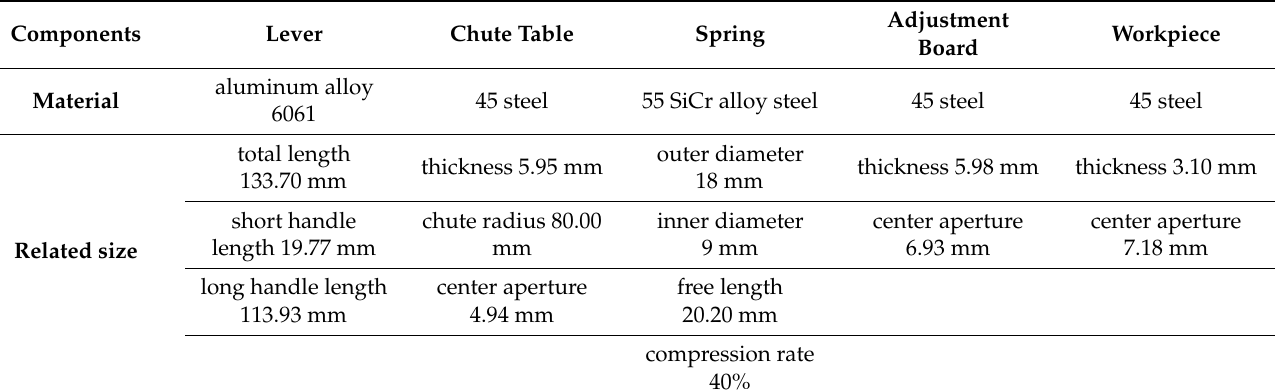
Table 2. Main parameters of